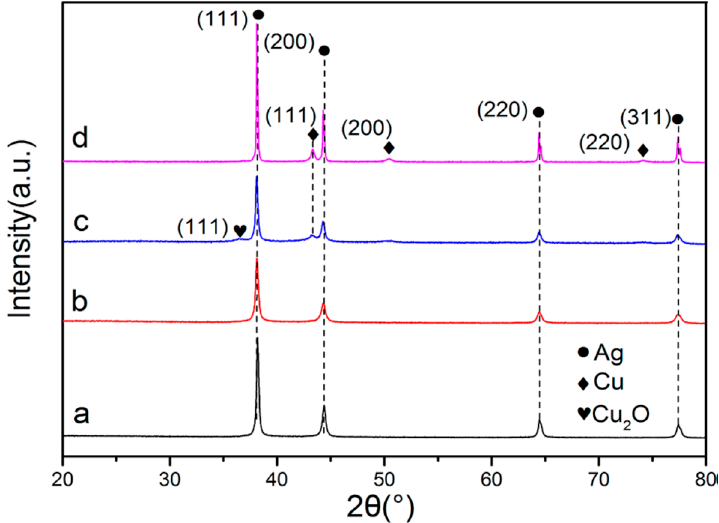
Figure 20. XRD spectra: (a) no Cu peaks in the spectrum of Ag 6 Cu; (b) no Cu peaks in the spec- trum of Ag 2 Cu; (c) peaks of Cu and Cu 2 O in the spectrum of AgCu 3 ; (d) peaks of Cu and Cu 2 O in the spectrum of AgCuO x . Reproduced with permission from Reference [272]. Copyright 2019, American Chemical Society.